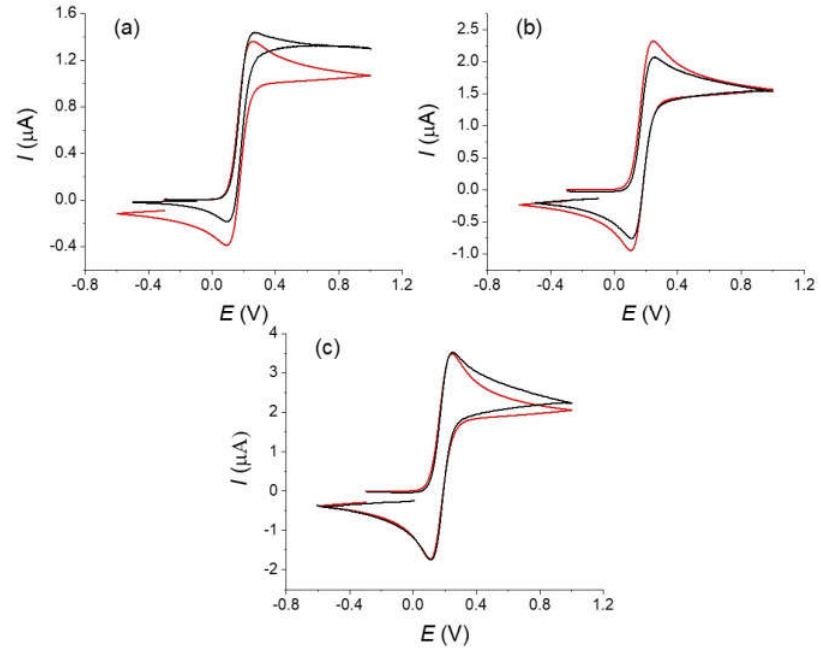
Figure 5. Simulations and experimental curves recorded on fully oxidized fibers (type 3) of a 1.10 −2 mol L −1 solution of potassium ferrocyanide in 0.5 mol L −1 KCl at different scan rates : ( a ) 0.01, ( b ) 0.1, 1.10 − 2 mol L − 1 solution of potassium ferrocyanide in 0.5 mol L − 1 KCl at different scan rates : ( a ) 0.01, ( c ) 1 V s -−1 . Parameters of the simulations are: r = 4.5 µm; l = 1.05 mm; α = 0.5; E° = 0.17 V; k s = 0.025 ( b ) 0.1, ( c ) 1 V s − 1 . Parameters of the simulations are: r = 4.5 µ m; l = 1.05 mm; α = 0.5; E ◦ = 0.17 V; s −1 . Black lines are the experimental curves. Red lines are the simulations. k s = 0.025 s − 1 . Black lines are the experimental curves. Red lines are the